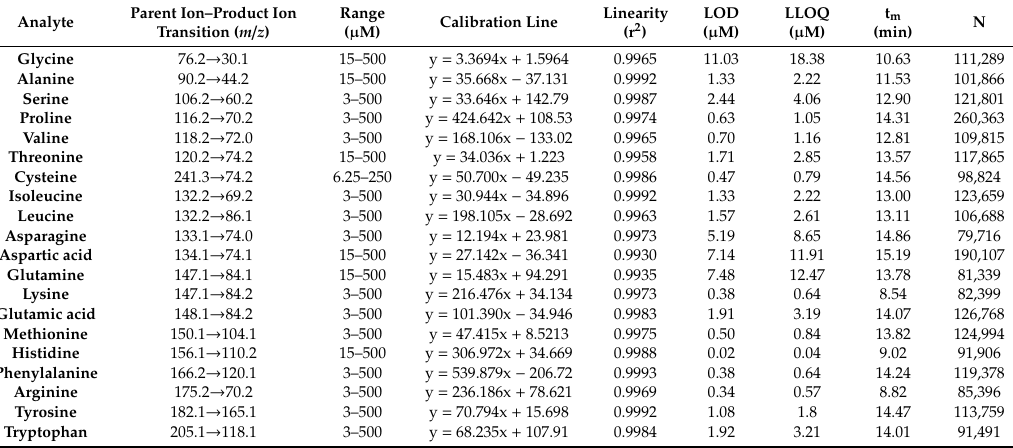
Table 1. Calibration and selected analytical parameters of the CE-MS / MS method for 20 amino acids in model water